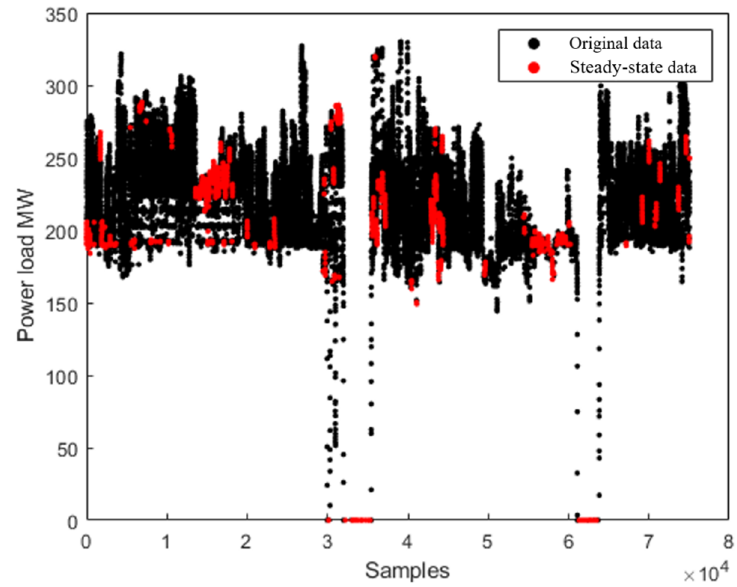
Figure 3. The results of steady-state data screening.